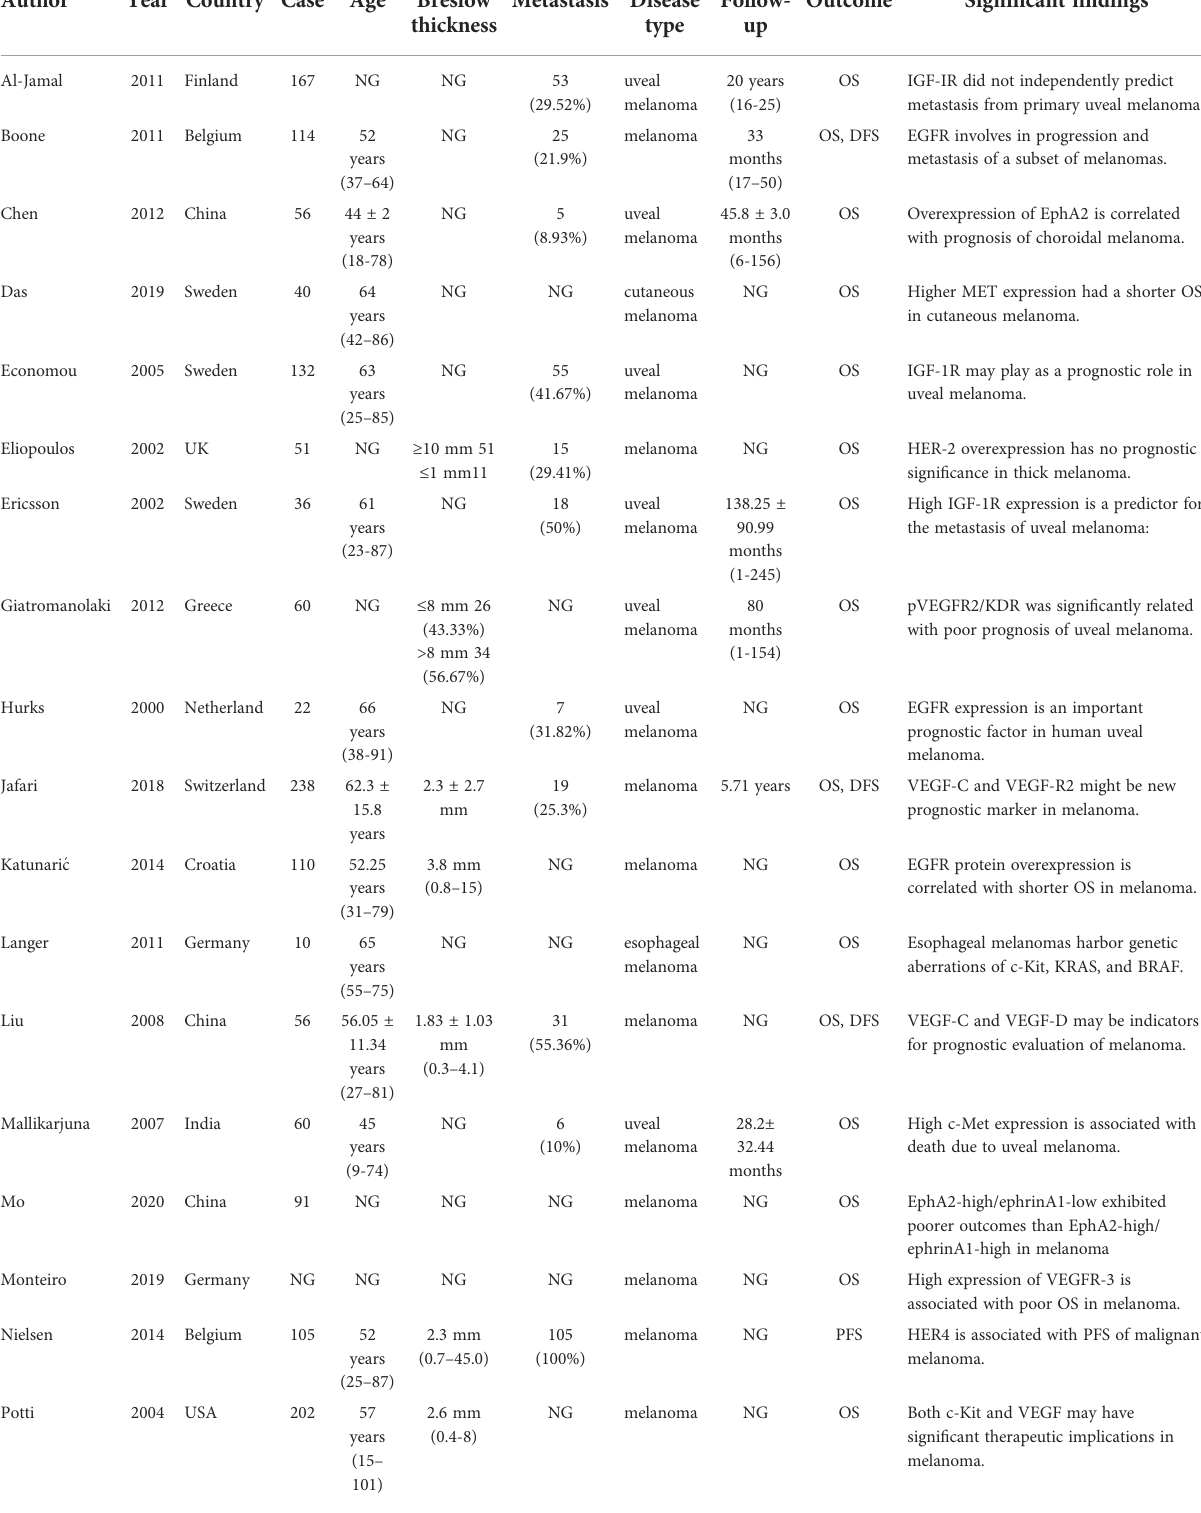
TABLE 1 Characteristics of included